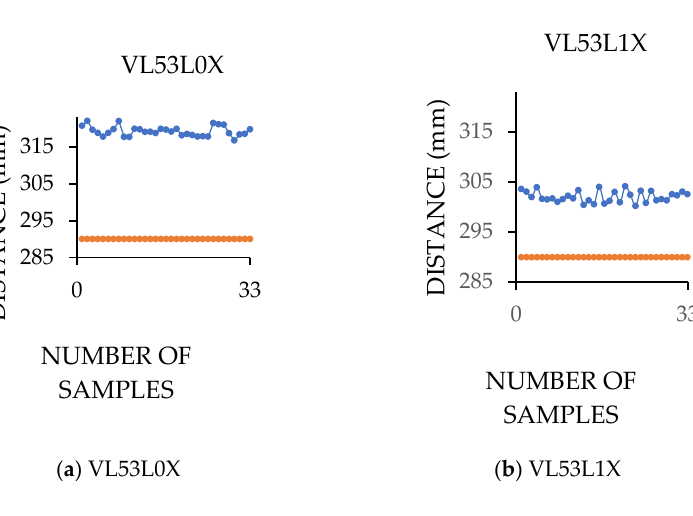
Figure 10. Combined outputs of similar sensors.